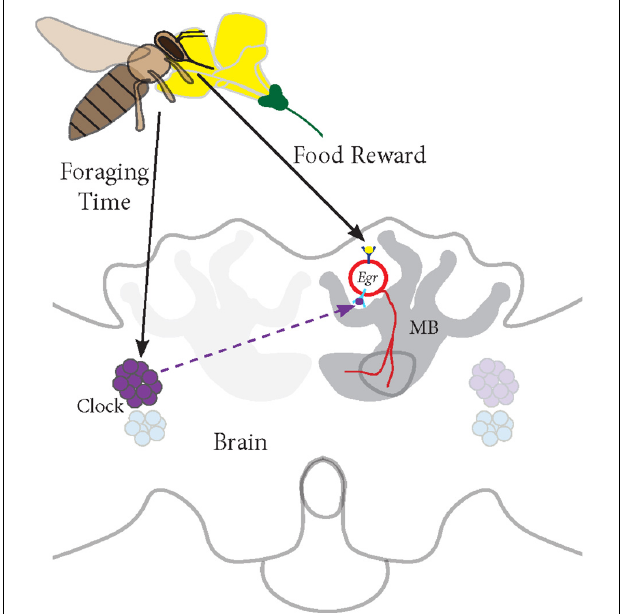
FIGURE 7 | Proposed model for Egr-1 function in honey bee foraging: (a) Foraging/food reward leads to an up-regulation of Egr-1 in the sKCs, which in turn regulates the expression of downstream targets that are involved in learning and memory. (b) Time-Restricted foraging at one food source leads to entrainment of the molecular clock. This effect might be restricted to a specific population of clock cells. For example, different populations of clock cells might be involved in foraging entrainment and time-compensated sun compass navigation. (c) Time-training over several days leads to an anticipatory up-regulation of Egr-1 that is controlled by the circadian clock. Thus, Egr-1 expression in the Kenyon cells of the mushroom bodies might be regulated via two signaling mechanisms, one from food reward related pathways and one from the circadian